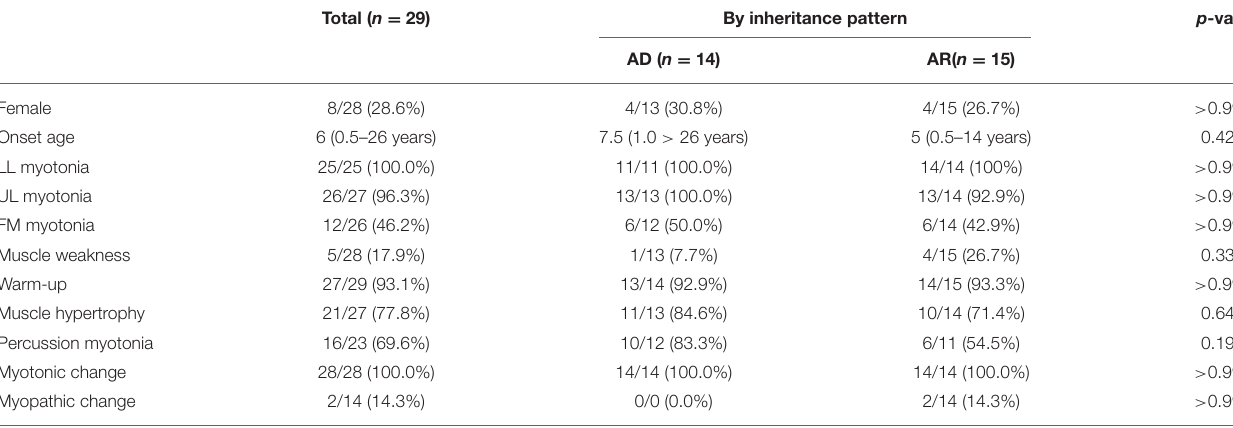
TABLE 2 | There was no significant difference in clinical presentation between AD and AR inherited MC patients in China.